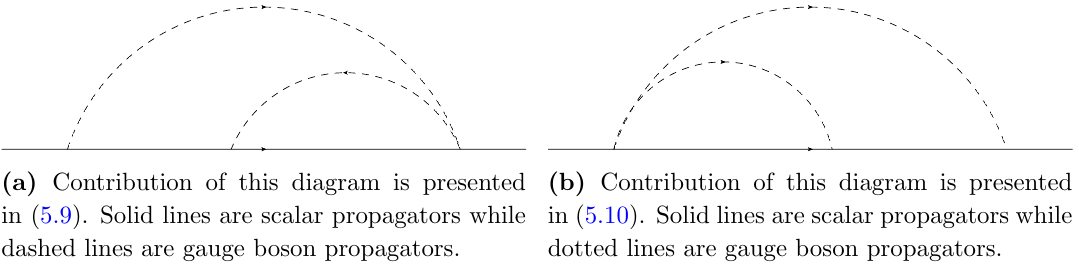
Figure 10. The ‘one loop’ and one of the ‘two loop’ graphs that contribute to the bosonic self energy. Note that the contribution of the one loop graph vanishes in the absence of a magnetic (cid:12)eld.